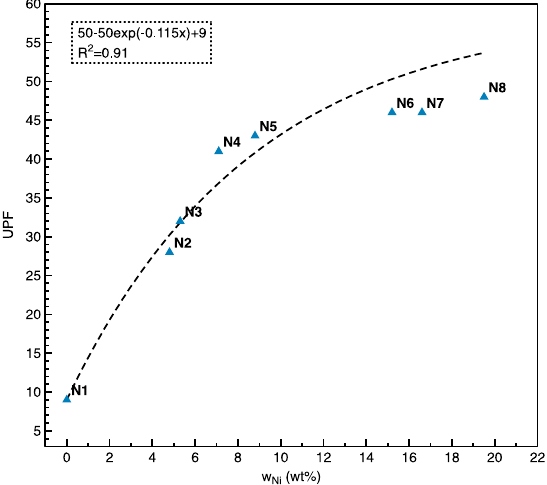
Figure 10. The relationship between UPF and w Ni .